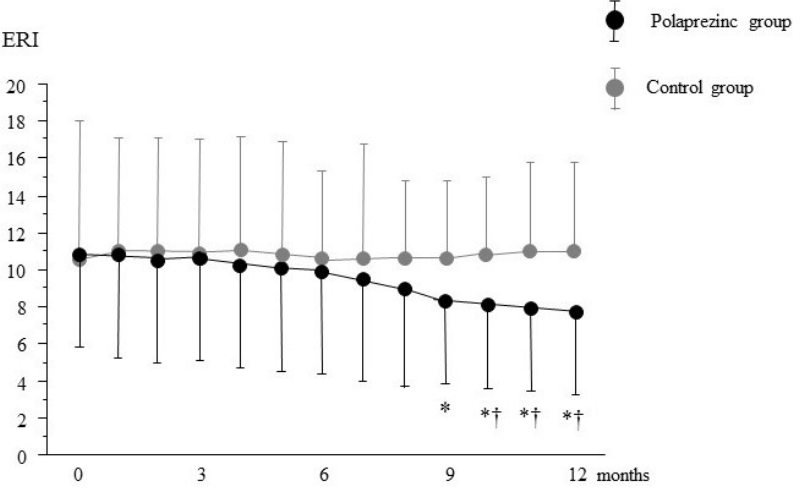
Figure 3. Changes in erythropoietin responsiveness index (ERI) during the study period. Data are expressed as mean ± SD, * p < 0.05 vs. baseline, † p < 0.05 vs. control